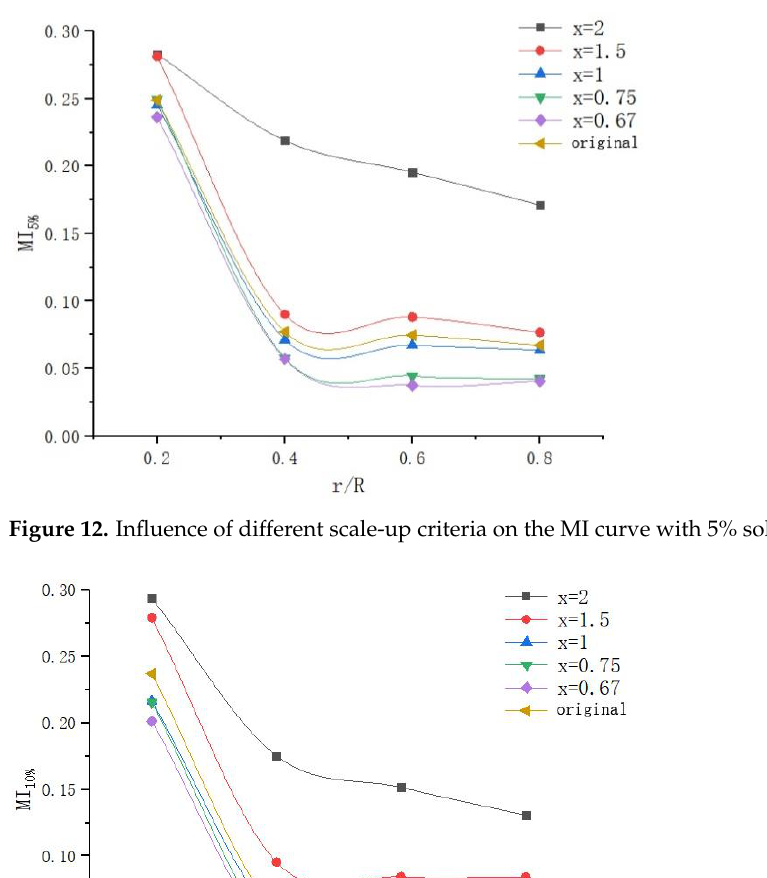
Figure 12. Influence of different scale-up criteria on the MI curve with 5% solid volume fraction.